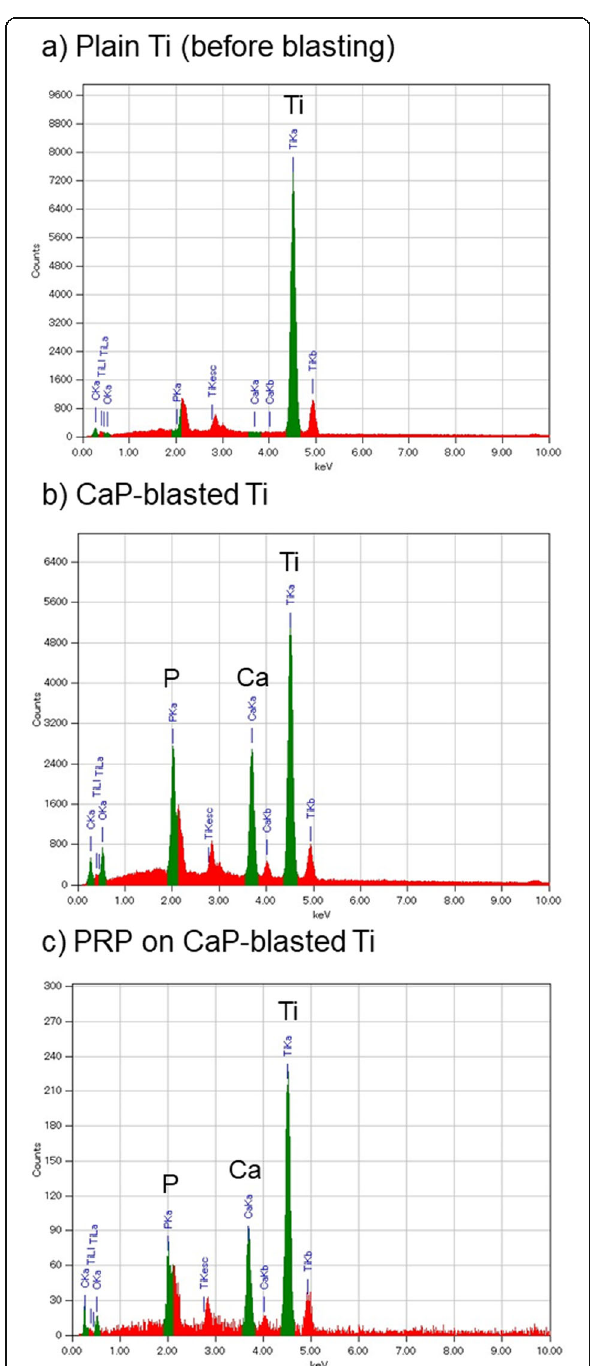
Fig. 4 Elemental analysis of plain and CaP-blasted cp-Ti plate surfaces. a Plain cp-Ti plate before blasting, b CaP-blasted cp-Ti plate, and c PRP-treated, CaP-blasted cp-Ti